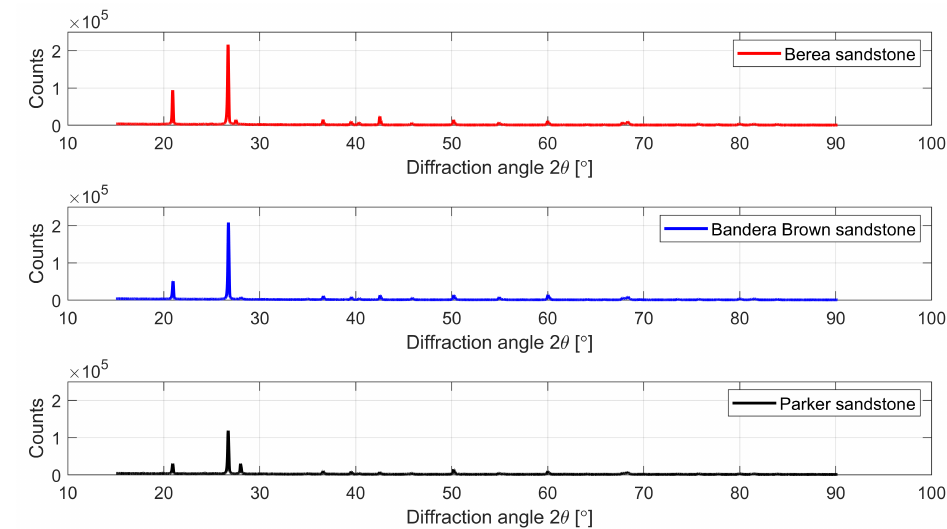
Figure 3. Results of X-ray power diffraction (XRD) analysis of Berea, Bandera Brown, and Parker sandstone materials.